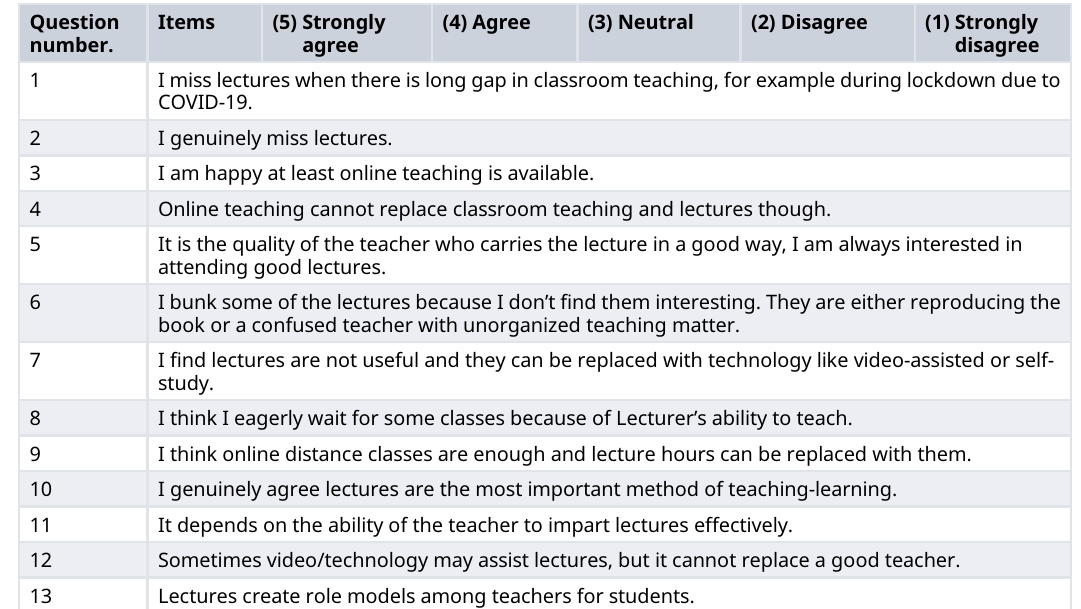
Table 1. The 13 items of the questionnaire and Likert scale ranging from SA (Strongly agree-5), A (Agree-4), N (Neutral-3), D (Diasagree-2) to SD (Strongly disagree-1). Question